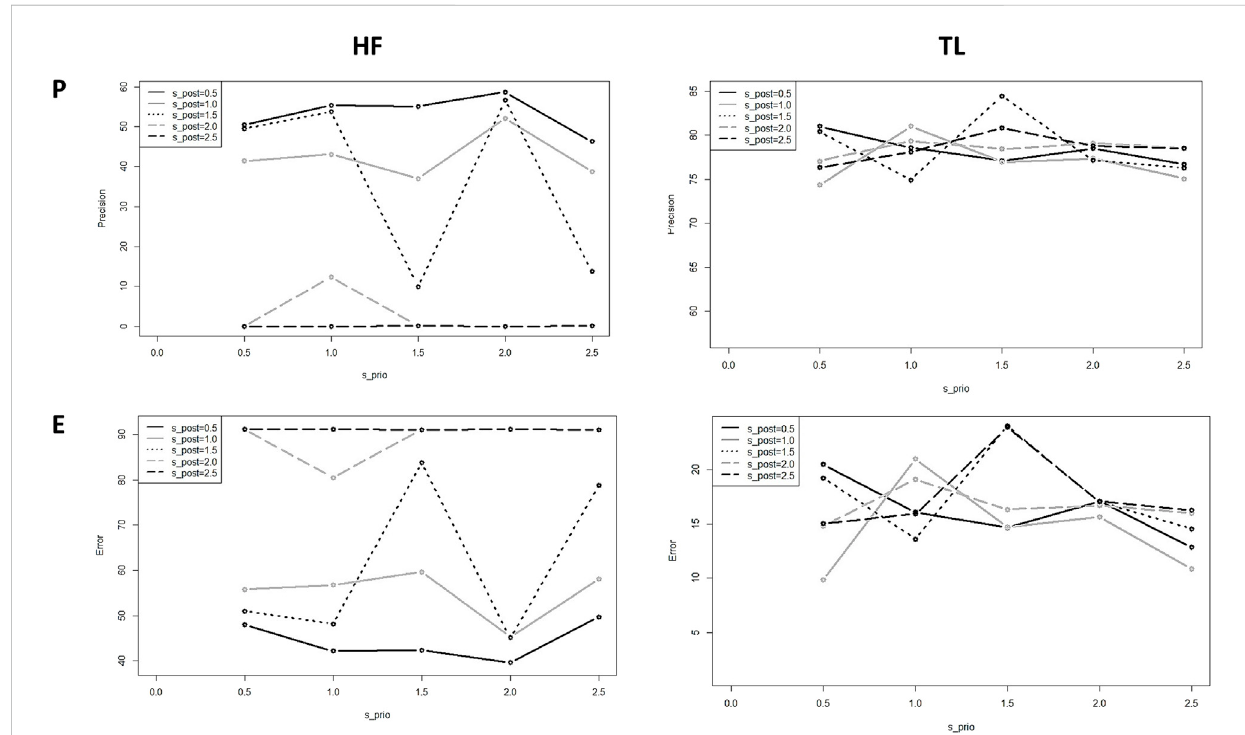
FIGURE 8 Precision and error of the predicted HF and TL using BNNs for different standard deviations; σ pr ( x -axis), and σ po (different shapes).